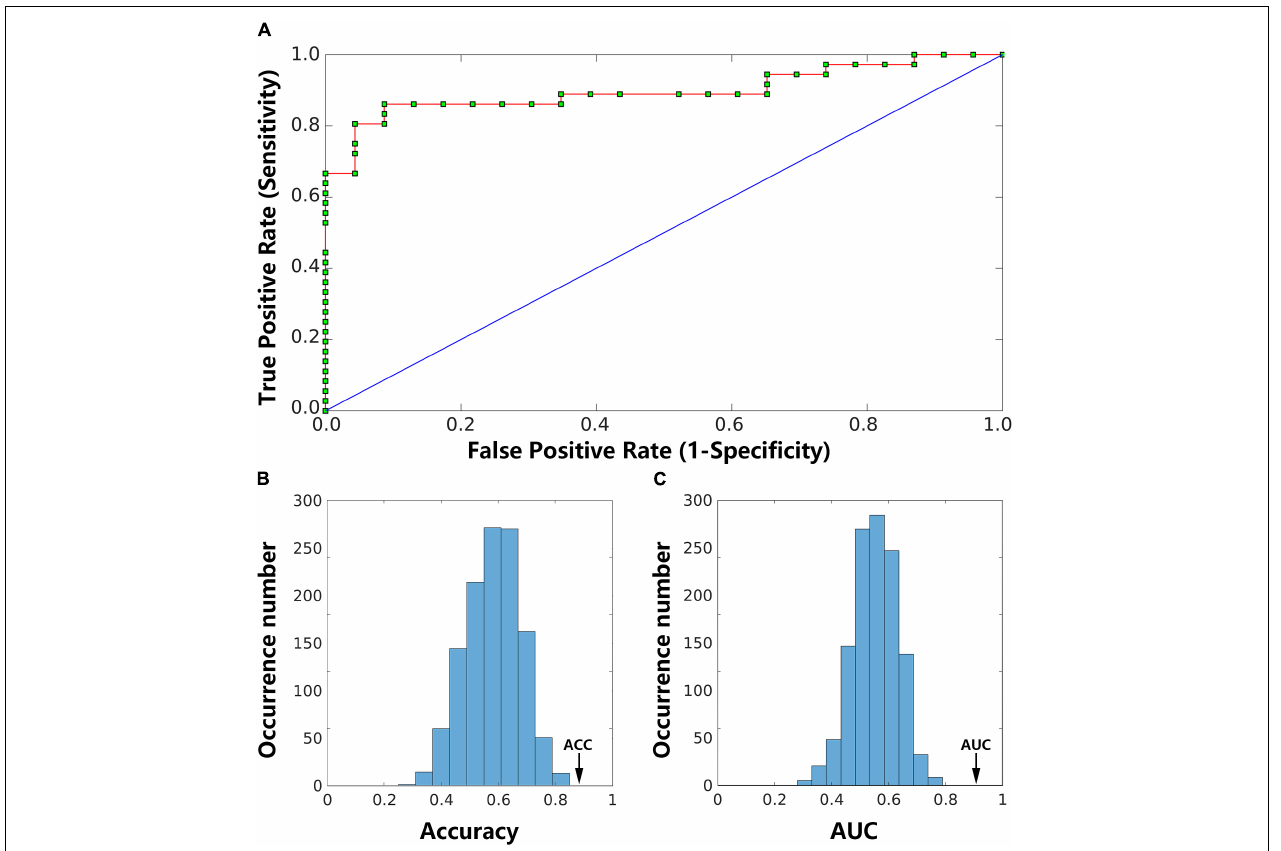
FIGURE 5 | Classification results. The receiver operating characteristic (ROC) curve for the classifier using dynamic functional connectivity (DFC) state features achieved an area under the curve (AUC) of 0.91 (A) . Two histograms below are the permutation distribution of the accuracy (ACC; (B) and AUC (C) for the feature-based classifier. The values obtained using the real labels are indicated by the